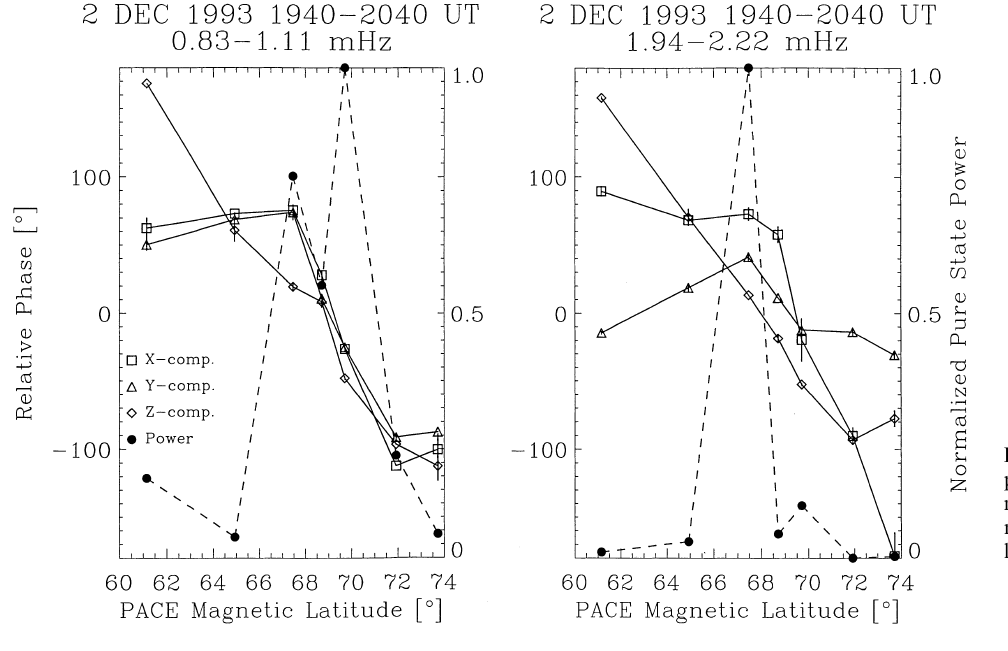
Fig. 12. Poleward phase propagation of 1 and 2-mHz magnetic pulsations. Also, normalized pure state power latitude profiles are shown